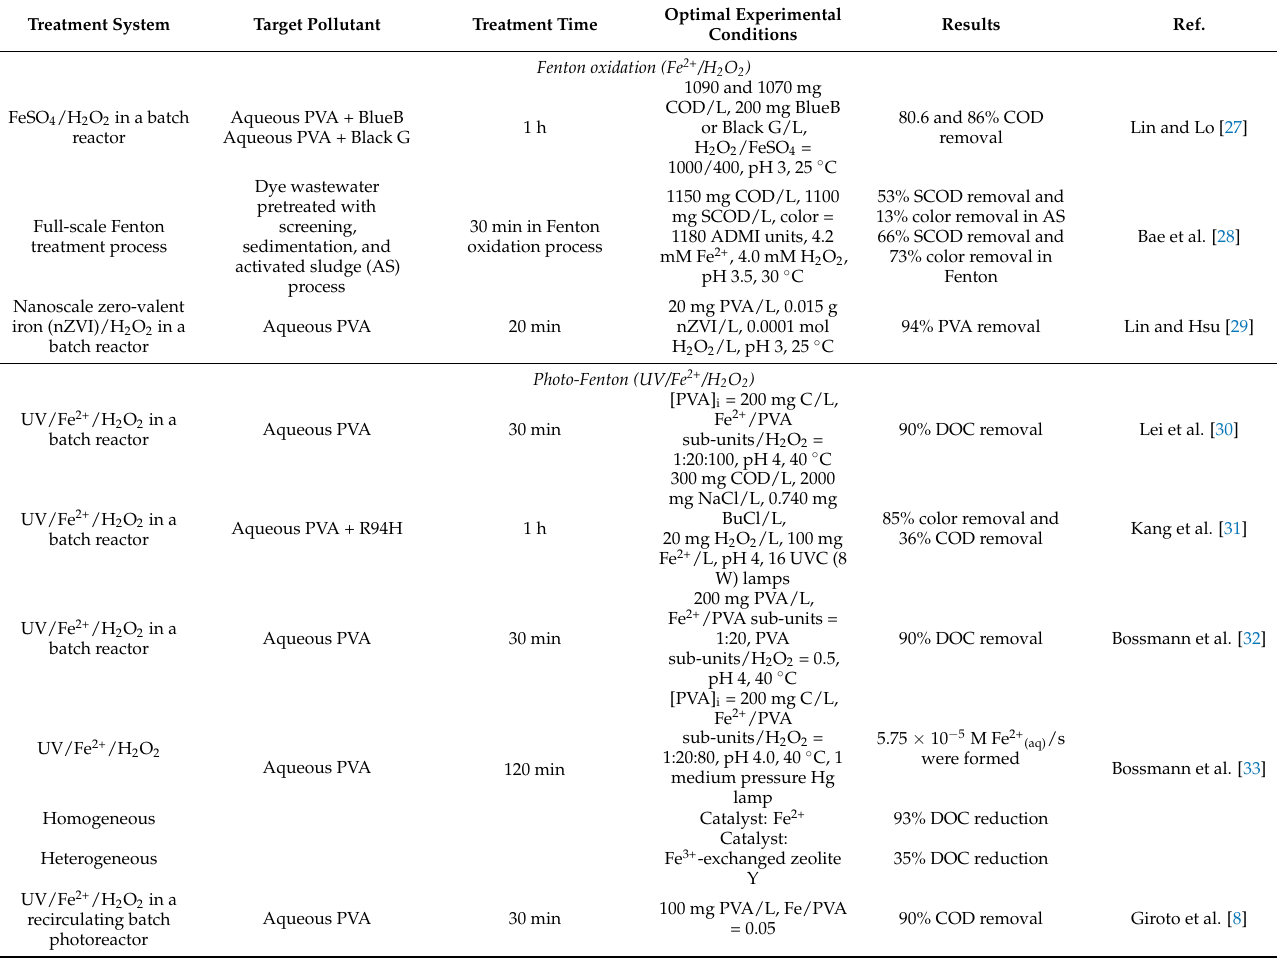
Table 2. Chemical-based and photochemical-based